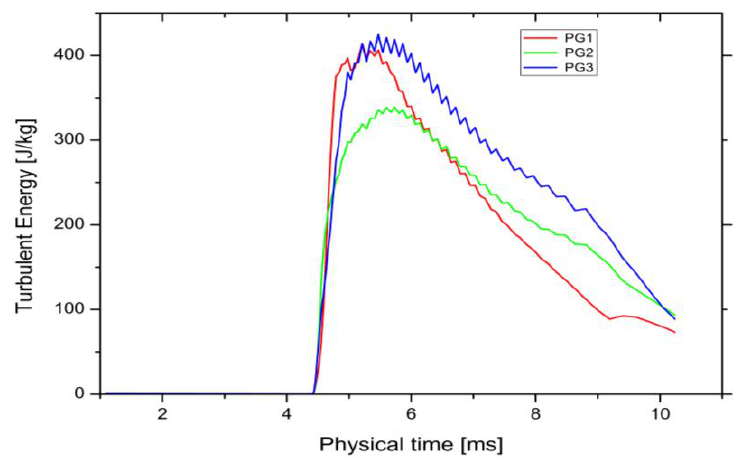
Figure 12. Unsteady in-cylinder turbulent energy for H 2 CNG50.